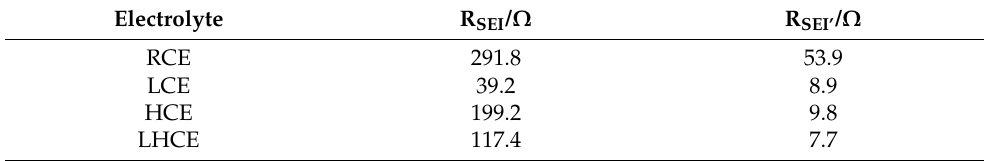
Table 2. Interfacial film impedance values before and after the CV cycle for four electrolytes. Electrolyte